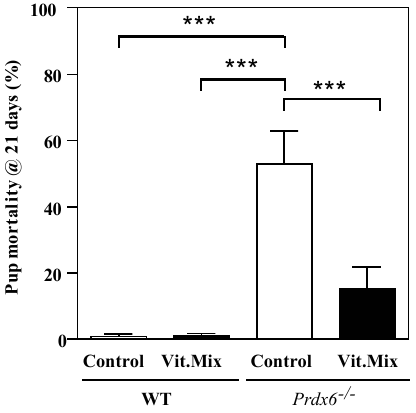
Figure 3. Mortality of pups sired by WT or Prdx6 − / − males fed with control (open bars) and Vit. Mix (black bars) diets, respectively. *** p ≤ 0.001, two ‐ way ANOVA and Tukey tests.